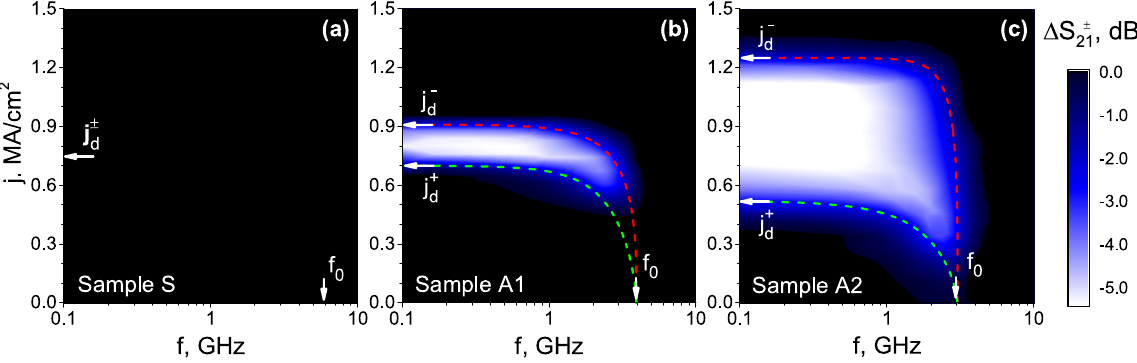
Figure 3. Difference signals ∆ = ∆ − ∆ ± + − S S j S j ( ) ( ) for sample S ( a ), A1 ( b ), and A2 ( c ) at T = 0.3 T c and 21 21 21 the fundamental matching field H m = 7.2 mT. The arrows indicate the zero-bias depinning frequencies f d ( j = 0) and the depinning current densities + j and − j for the motion of vortices against the gentle and steep slope of the d d grooves, respectively. The dashed lines are fits of the general form f d / f d ( j = 0) = [1 − ( j / j d ) k / l ] m / n , with exponents k , l , m , n indicated in Fig.